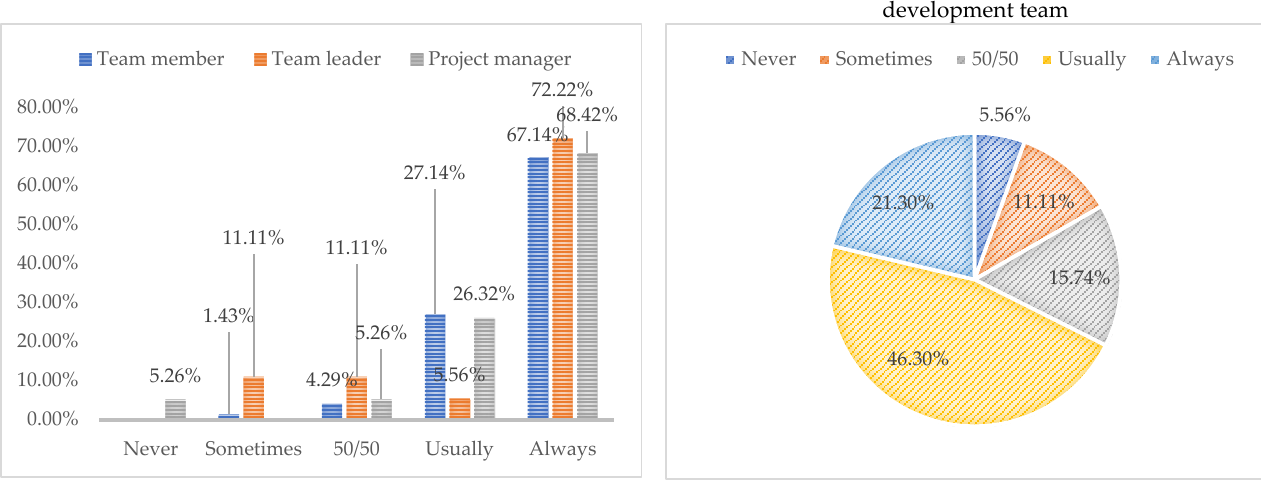
Figure 1. Identification of risk factors during project planning (n = 108).